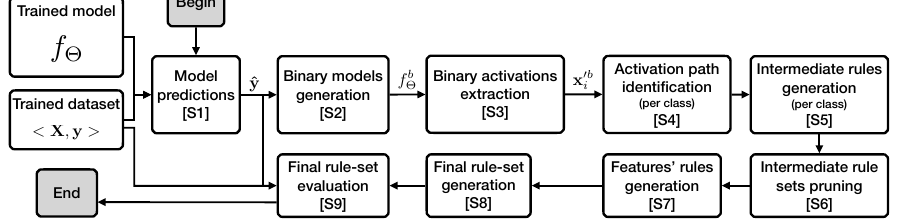
Figure 3. DEXiRE pipeline describes the series of steps executed by the DEXiRE algorithm (Algorithm